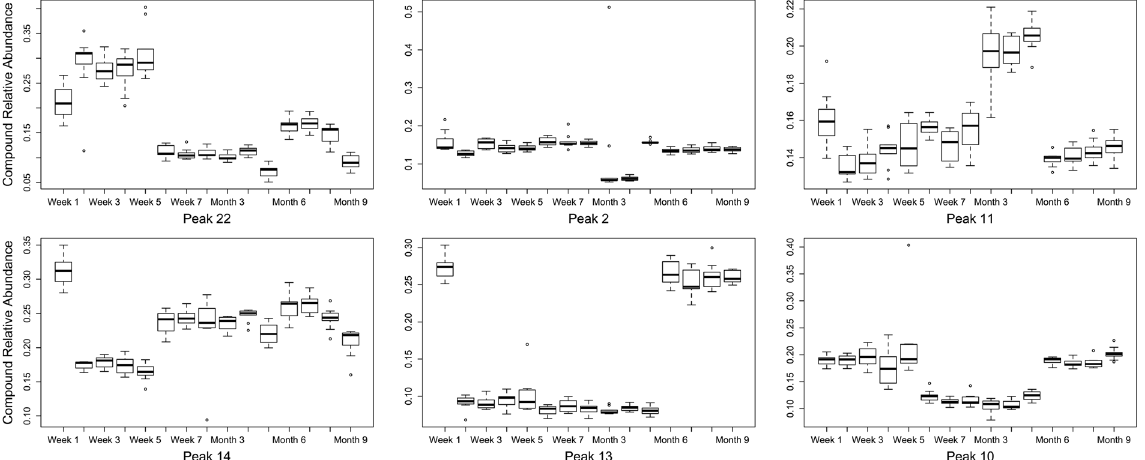
Figure 6. The top six hydrocarbon compounds identified that contributed to the most variation in Calliphora vicina puparial case age (1 week to 9 months): Hentriacontene (Peak 22), 2-Methylhexacosane (Peak 2), 12 + 15 + 16-Methyloctacosane (Peak 11), x,10/x,12/x,14di-Methyloctacosane (Peak 14), 2-Methyloctacsane (Peak 13), and Trimethylpentacosane (Peak 10). The solid black line across the color box represents the median value, while a hollow circle indicates an outlier